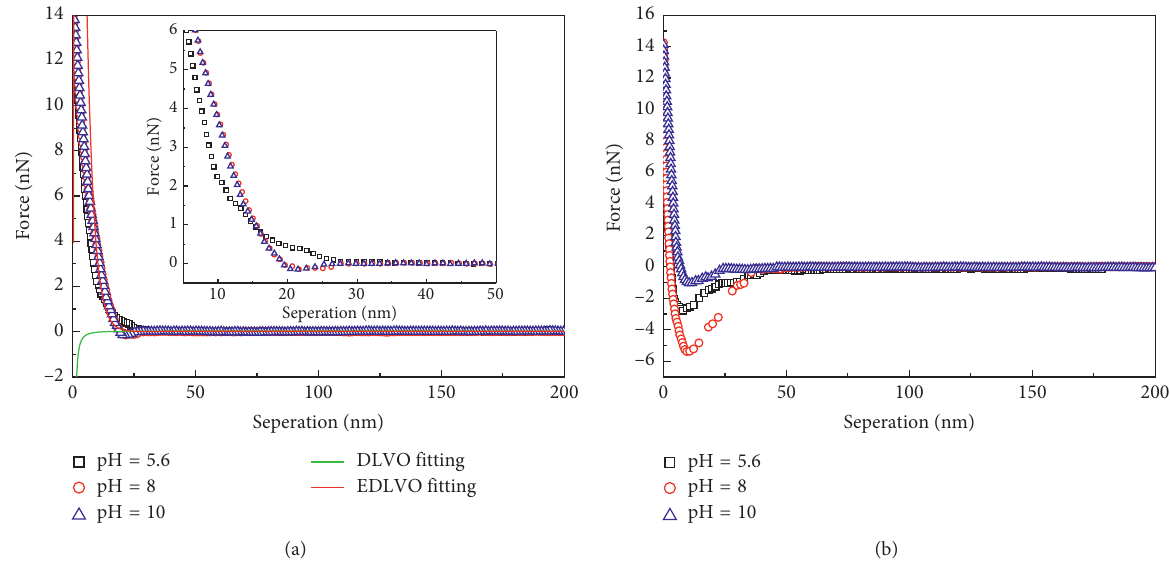
Figure 14: The interaction forces between scheelite particle and fluorite substrate in ultrapure water solution: (a) approach curves; (b) retraction curves.